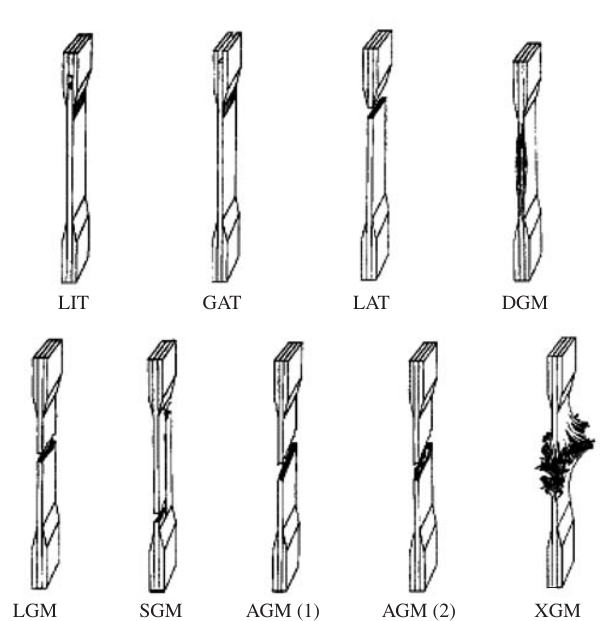
Figure 2. Representation of some typical failure modes in tensile tests of composites 20 .